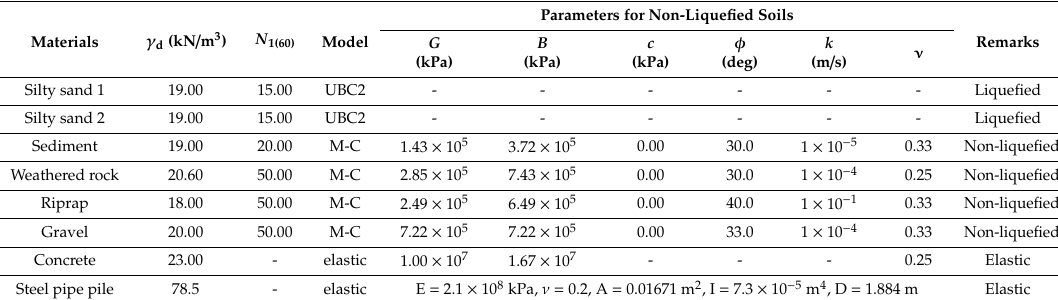
Table 3. Material properties